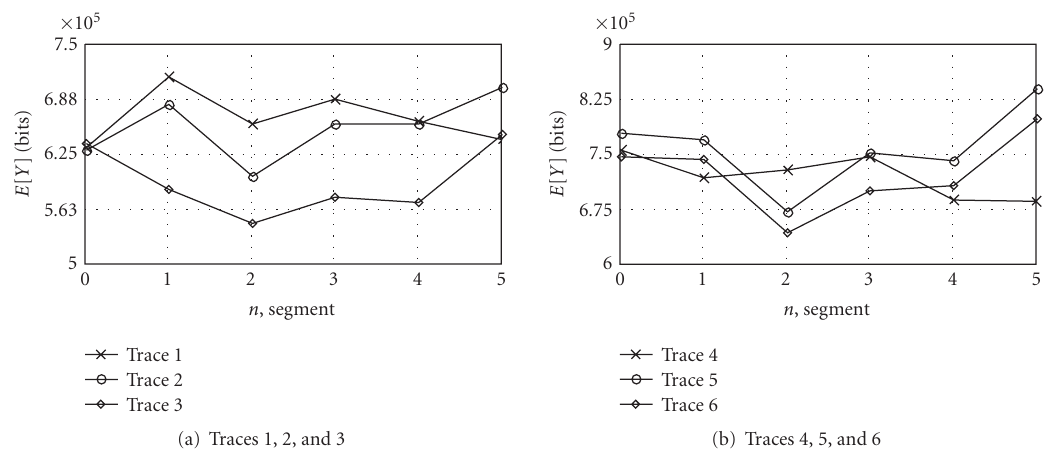
Figure 5: Mean values of